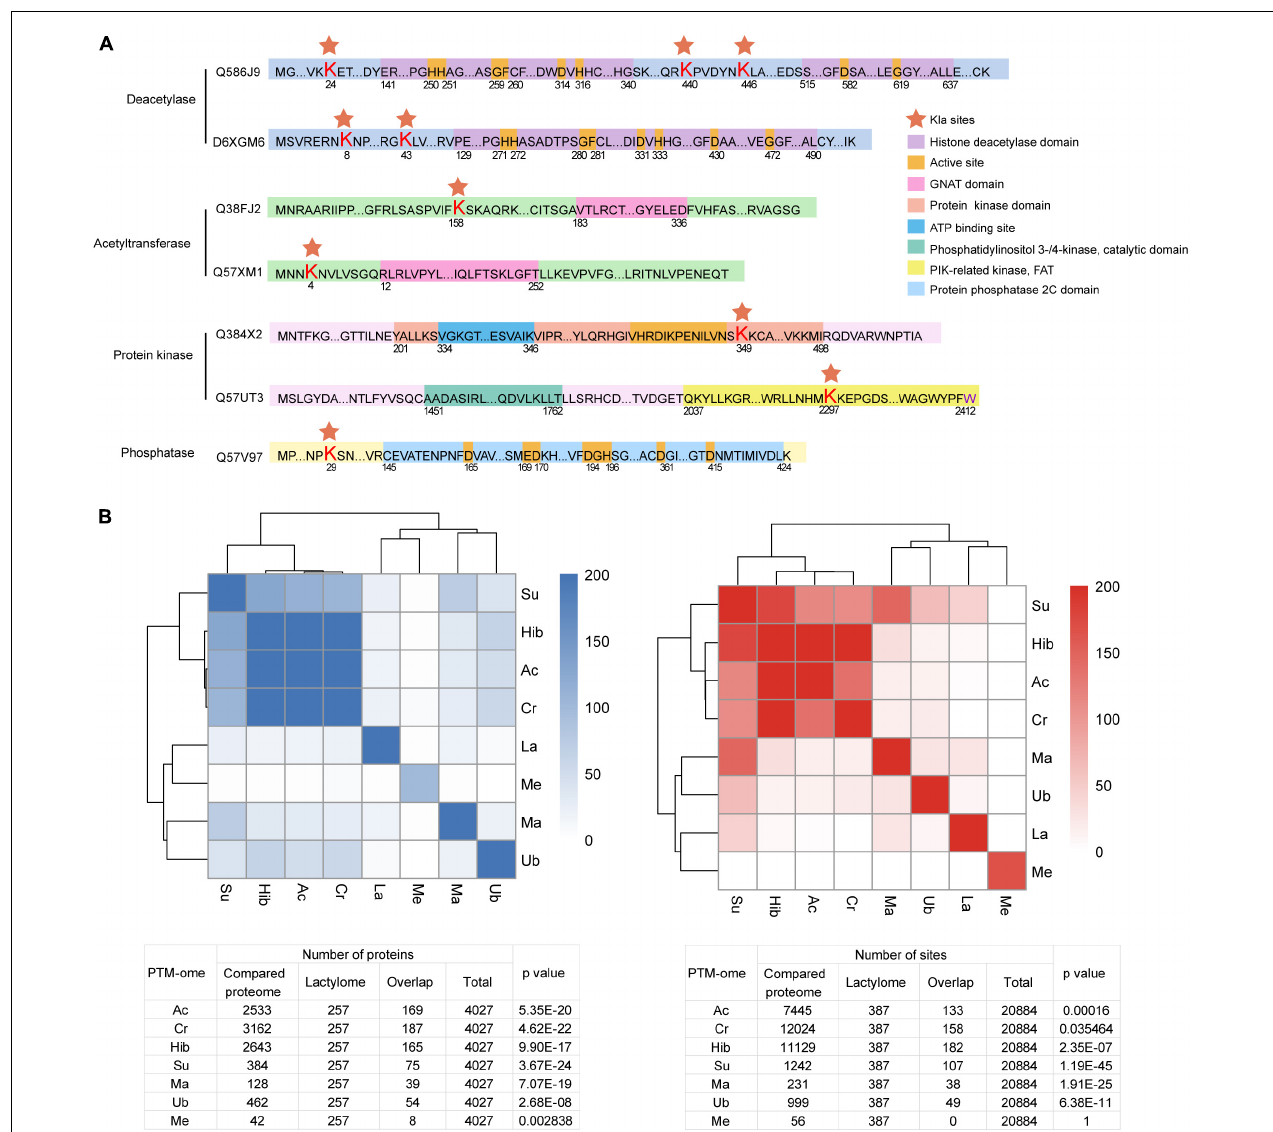
FIGURE 6 | Overview of Kla sites identified on T. brucei “writers” and “erasers.” (A) Red pentagrams: Lys lactylation sites. Domains are marked with different colors. (B) Heatmaps and tables displaying the significance ( − Log10 p value) of the overlaps of PTM datasets with one